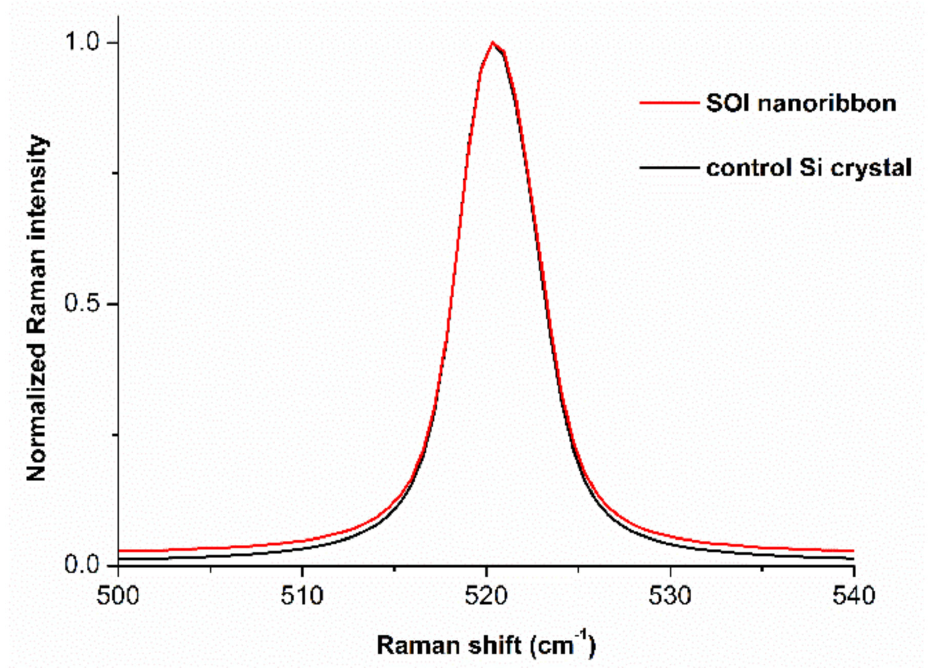
Figure 4. Typical normalized Raman spectra, obtained for the control silicon crystal (Si) and for the silicon nanoribbon (SOI). The spectra were excited with a 514 nm Ar + laser